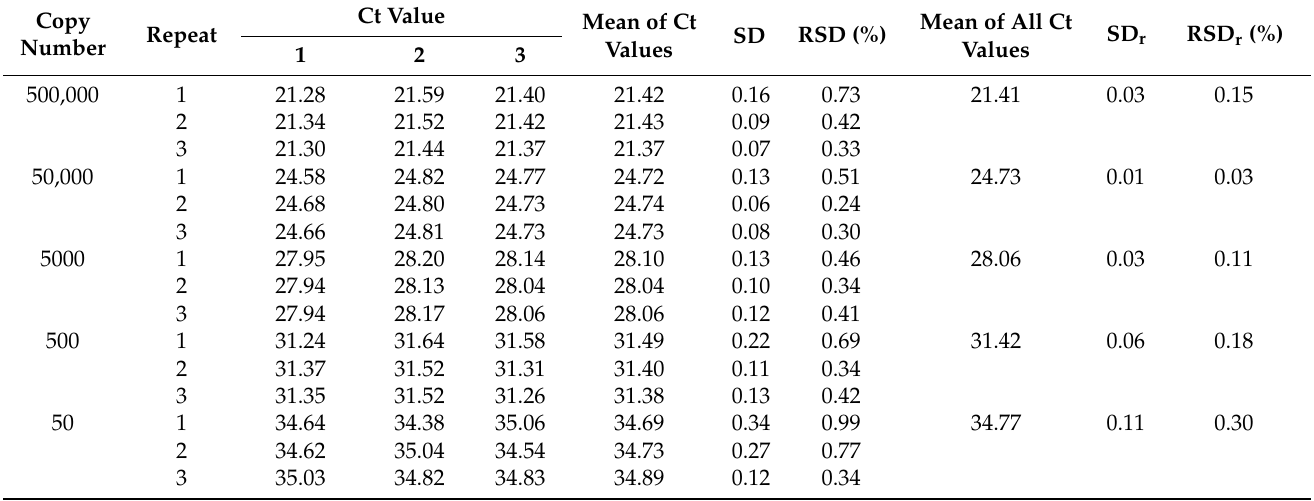
Table 3. Repeatability of Ct values of standard curves from qPCR.